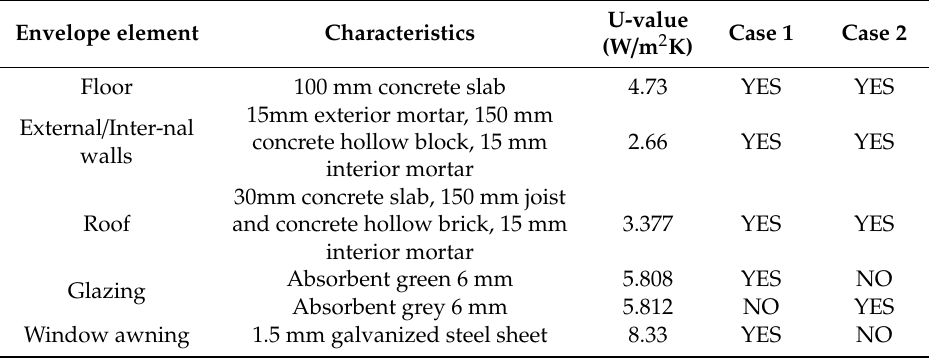
Table 3. Thermal envelope characteristics of each case